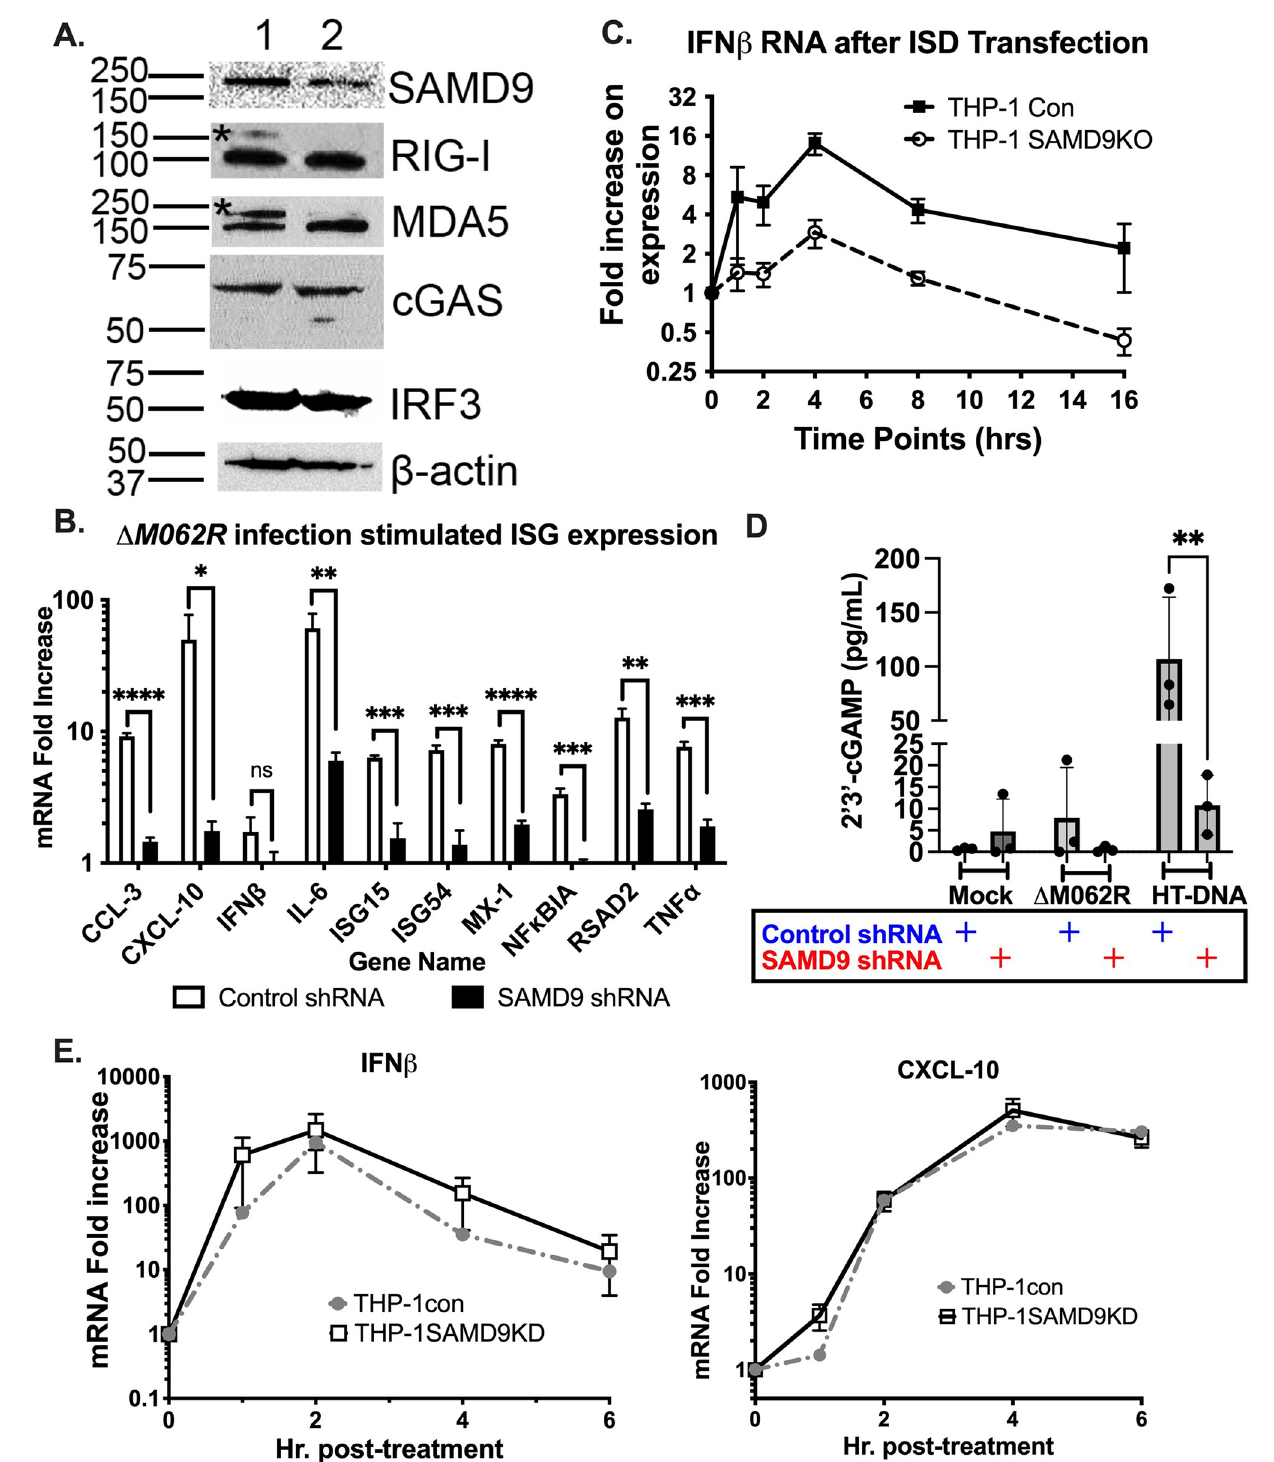
Fig 5. Knocking down SAMD9 expression attenuates the proinflammatory responses in THP-1 cells induced by Δ M062R infection and dsDNA. A. THP- 1 cells in which SAMD9 was knocked down by shRNA. A total protein of 25 μ g per cell line is loaded per sample. Western blotting shows reduced SAMD9 expression in THP-1 cells stably-transduced with lentivirus expressing SAMD9 shRNAs. Additional targets such as sensors RIG-I, MDA5, cGAS, and